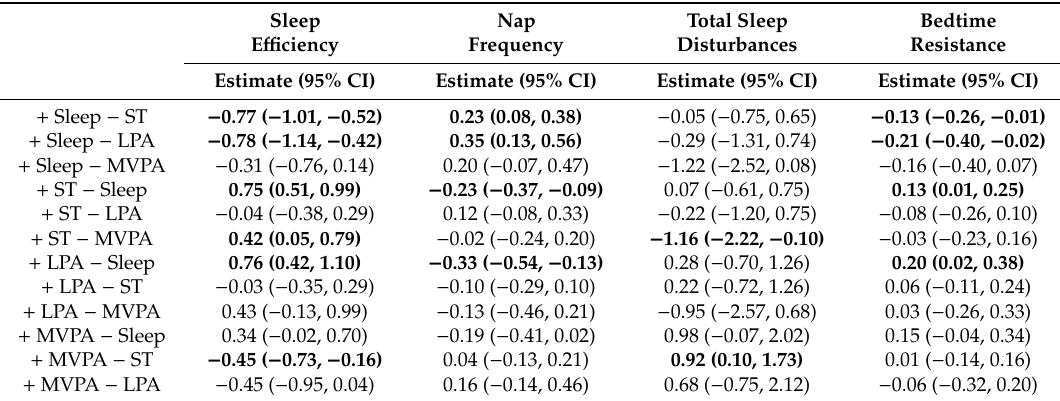
Predictive di ff erences in sleep outcomes following reallocation of 30 min between movement